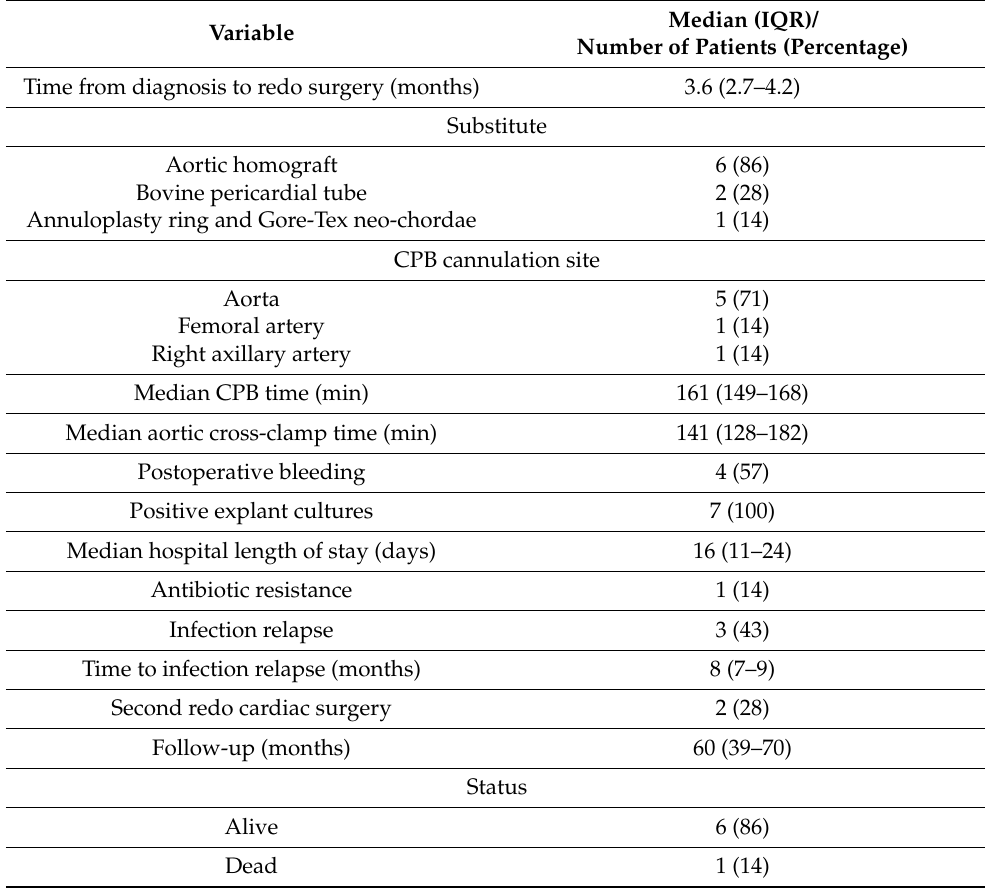
Table 3. Patients’ surgical characteristics at the first redo cardiac surgery and postoperative outcomes. Median (IQR)/ Variable Number of Patients (Percentage) Time from diagnosis to redo surgery (months) 3.6 (2.7–4.2) Aortic